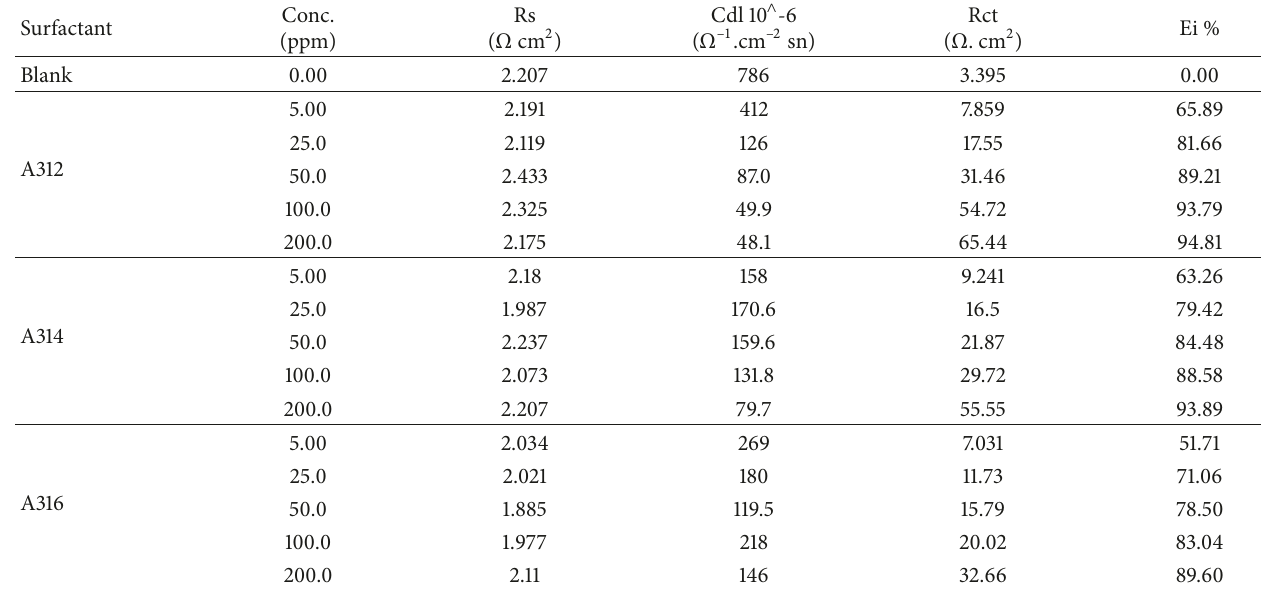
Table 4: Electrochemical impedance spectroscopy (EIS) for the corrosion of API X52 steel in 1 M HCl at various concentrations of the synthesized inhibitors at 25 ∘